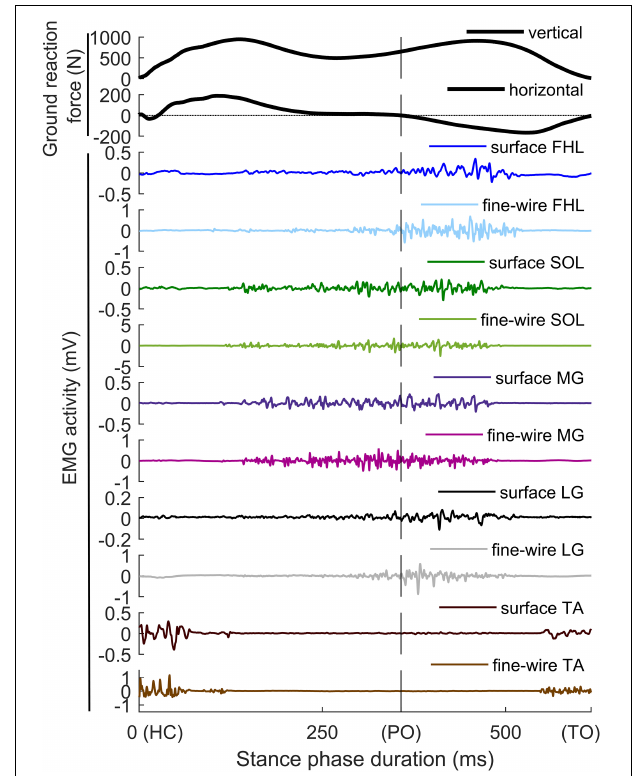
FIGURE 2 | Raw data from one step of one participant recorded during preferred speed walking. The top two panels show ground reaction forces (vertical and horizontal) measured with the force platform. The remaining panels show surface and intramuscular EMG activity of flexor hallucis longus (FHL), soleus (SOL), medial gastrocnemius (MG), lateral gastrocnemius (LG), and tibialis anterior (TA). HC, heel contact; PO, push-off start; TO, toe